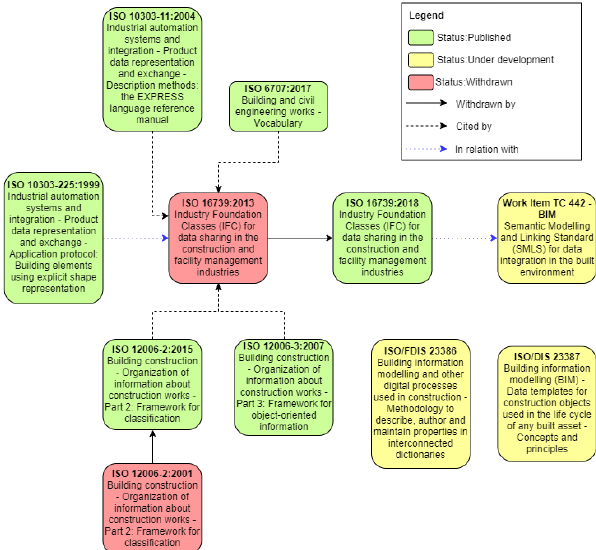
Figure 1 - Framework of the analysed standards